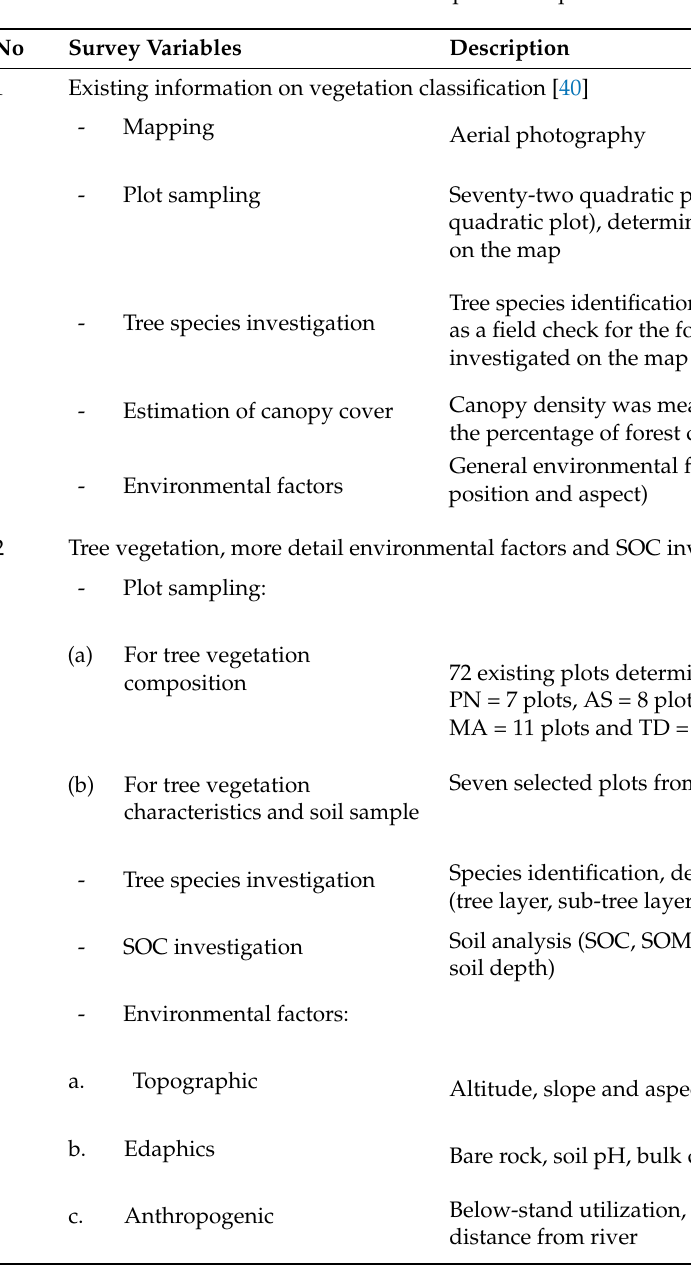
Table 2. Description of experimental